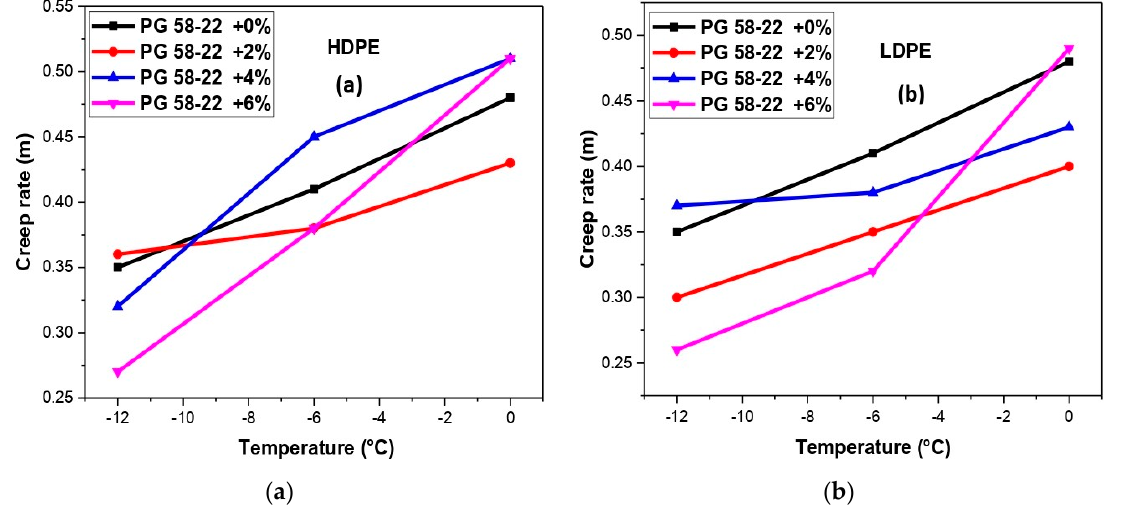
Figure 10. ( a ) An analysis of creep rate (m) and temperature with HDPE-modified bitumen, ( b ) analysis of creep rate (m) and temperature with LDPE modified bitumen.